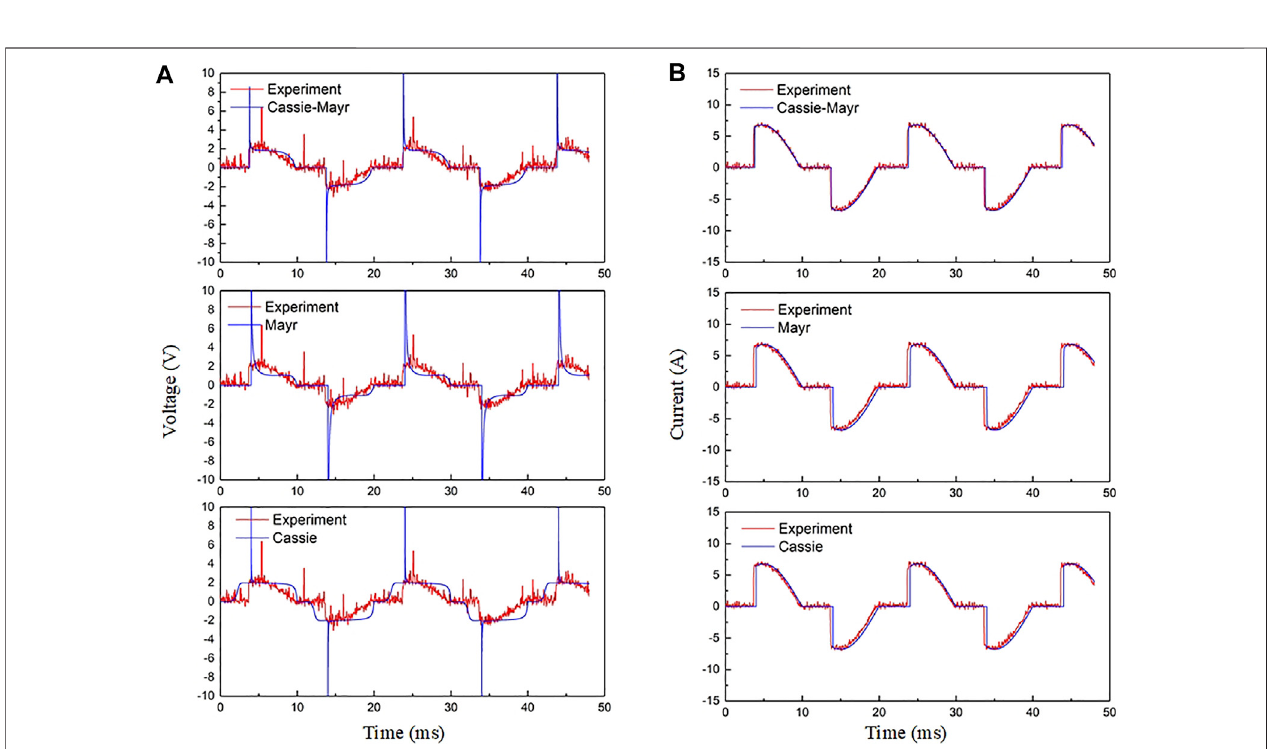
FIGURE 9 | Comparison between experiment, Cassie-Mayr, Cassie, and Mayr results of dimmer load. (A) Arc voltage; (B) arc current.